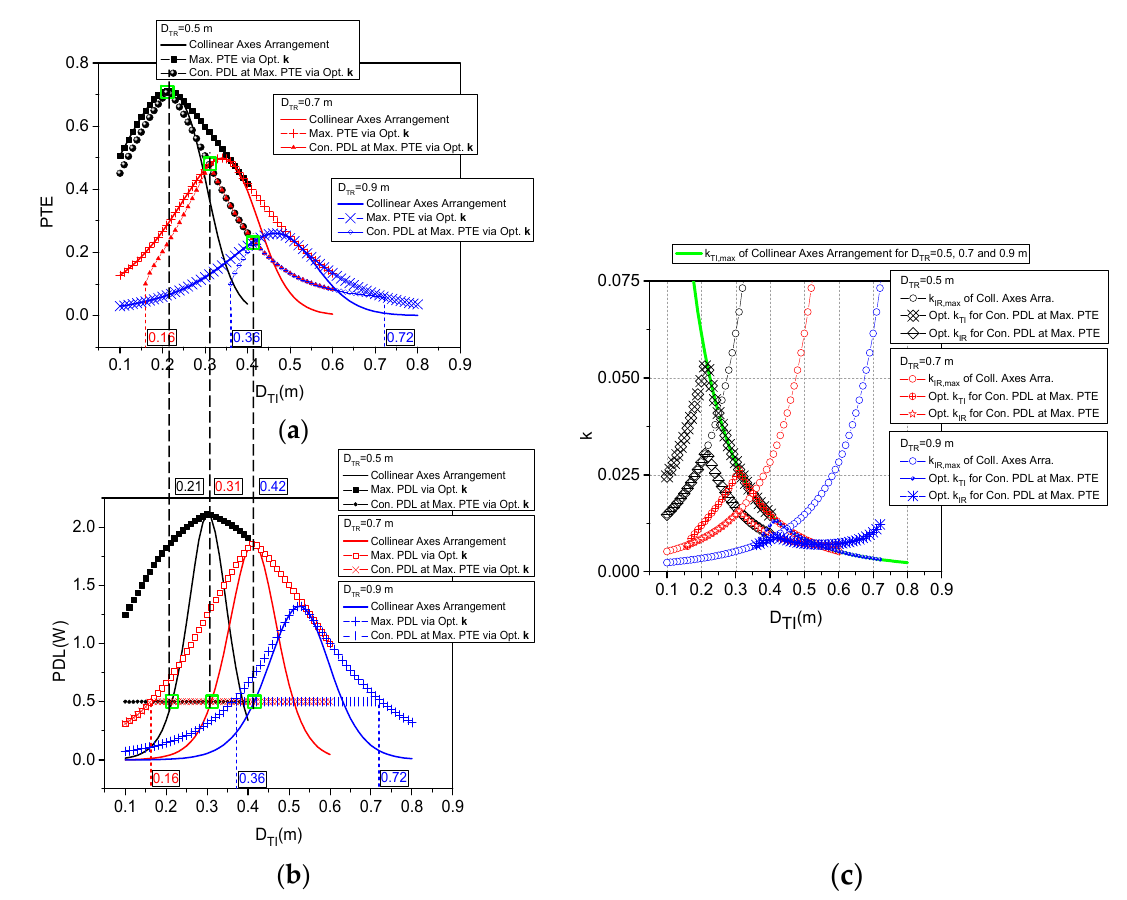
Figure 8. Predetermined ‐ goal of obtaining a constant PDL of 0.5 W at maximum PTE by optimizing coupling coefficient vector, k , in three ‐ resonator WPT: ( a ) PTEs of collinear axes arrangement scenario, maximizing PTE goal by optimizing k and obtaining a constant PDL at maximum PTE by optimizing k ; ( b ) PDLs of collinear axes arrangement scenario, maximizing PDL goal by optimizing k and obtaining a constant PDL at maximum PTE by optimizing k ; and ( c ) values of k for collinear axes arrangement scenario and obtaining a constant PDL at maximum PTE.